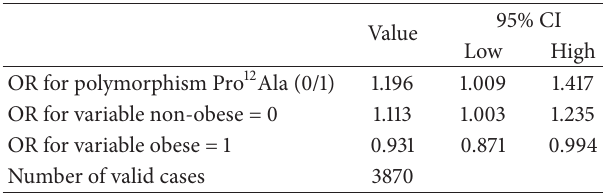
Table 7: Estimated risk of the Pro 12 Ala polymorphism with obesity.